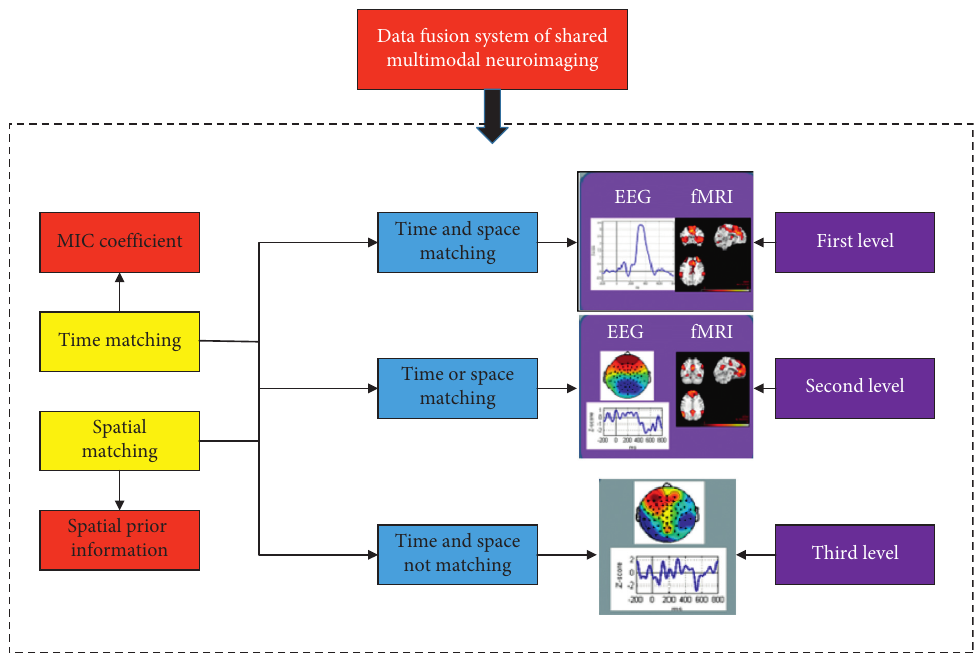
Figure 3: Realization of neuroimaging data fusion system based on shared